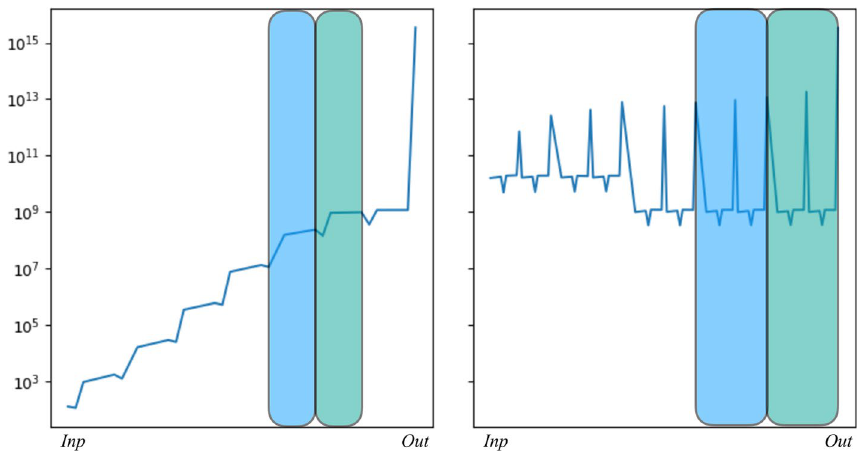
Fig. 10 Evolution of the SNR through the layers of a (left) layer-wise invertible model and (right) hybrid architecture model. The lower the SNR is, the more important numerical errors of the inverse reconstructions are. The x axis corresponds to layer indices of the model: right-most values represent the top layer of the model, in which the least noise is observed. Left-most values represent input layers in which maximum levels of noise accumulate. (Left): color boxes illustrate the span of two consecutive convolutional blocks (convolution–normalization–activation layers). The SNR gets continuously degraded throughout each block of the network, resulting in numerical instabilities. (Right): color boxes illustrate consecutive reversible blocks. Within reversible blocks, the SNR quickly degrades due to the numerical errors introduced by invertible layers. However, the signal propagated to the input of each reversible block is recomputed using the reversible block inverse, which is much more stable. Hence, we can see a sharp decline of the SNR within the reversible blocks, but the SNR almost raises back to its original level at the input of each reversible